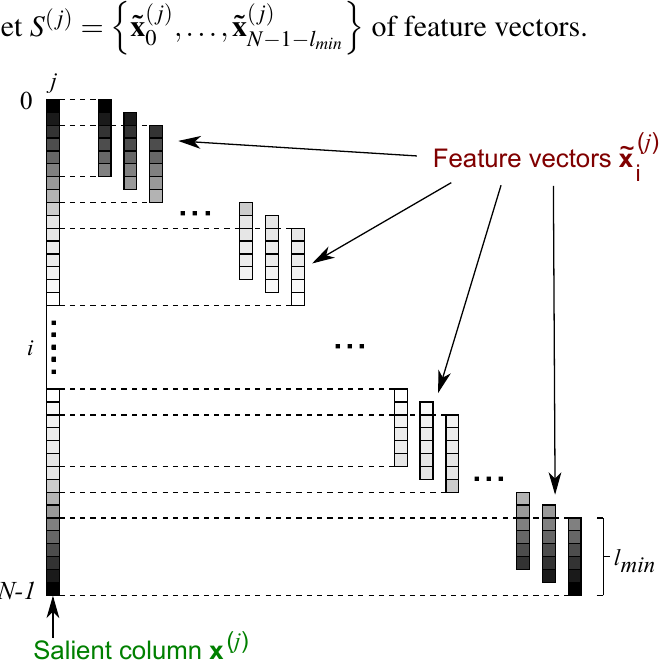
( j ) from a salient column x ( j ) (represented as i